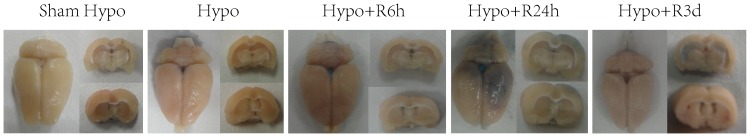
Moderate breakdown of BBB after recovery from hypoglycemia.Evans blue was used to determine the BBB's permeability to plasma protein. No leakage of Evans blue was evident during hypoglycemia but leakage was present 24 h post recovery.